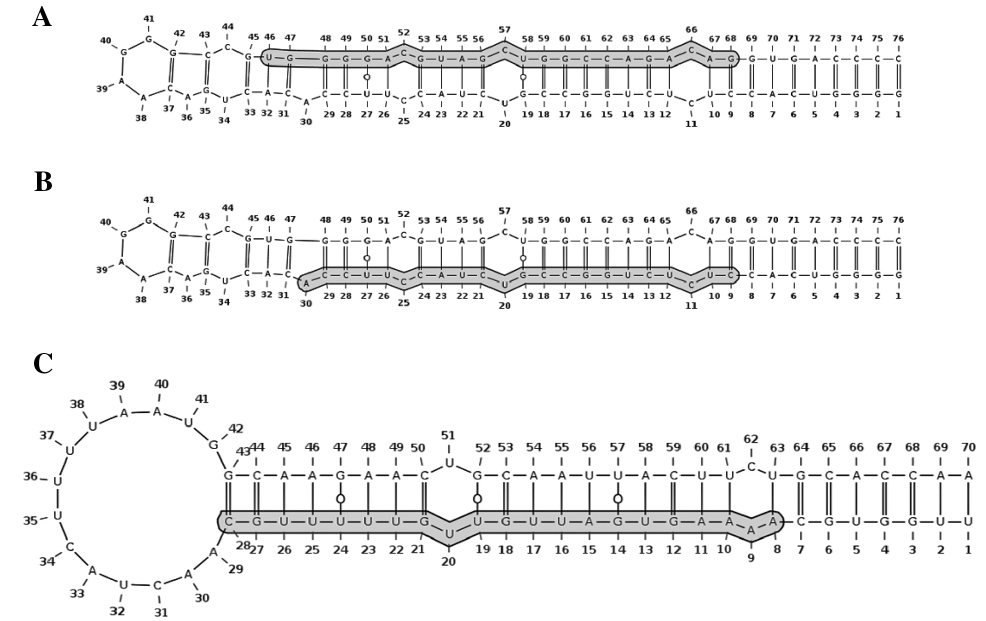
Figure 3: The pre-miRNAs predicted from BCC3 and TAB2 . The mature miRNAs similar to known human miRNAs are highlighted with a grey background. A) One hairpin predicted from the BCC3 similar to the mature miRNA hsa-miR- 3191-3p. B) One hairpin predicted from BCC3 gene similar to the mature miRNA hsa-miR-3191-3p. C) One hairpin pre- dicted from TAB2 gene similar to the hsa-miR-548au-5p